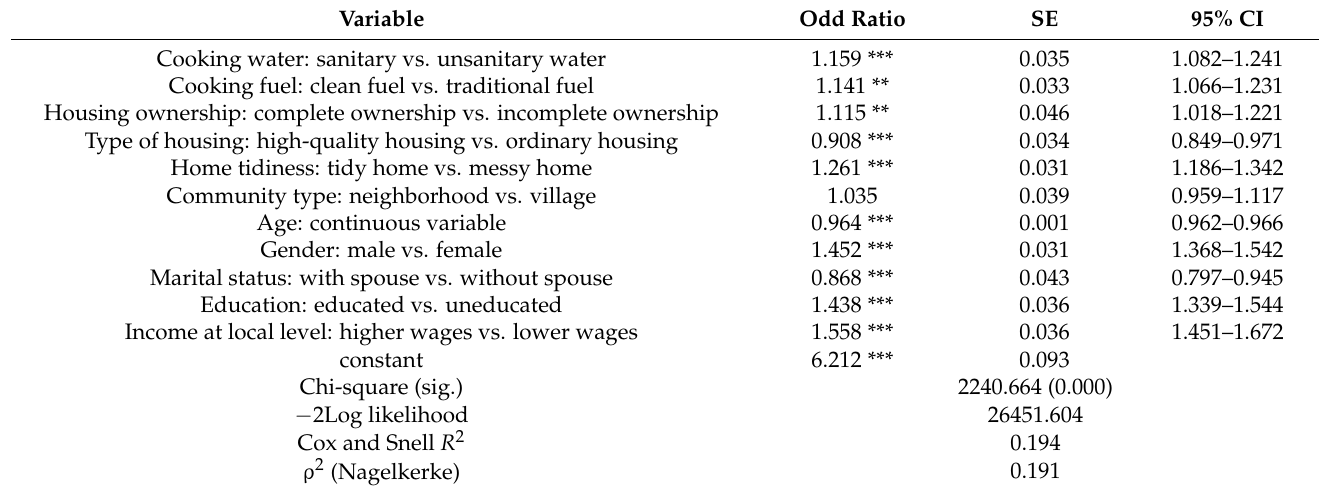
Table 3. Multivariable logistic regression analysis ( N =